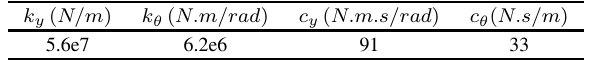
Table 1 Identi fi ed holder-tool interface parameters